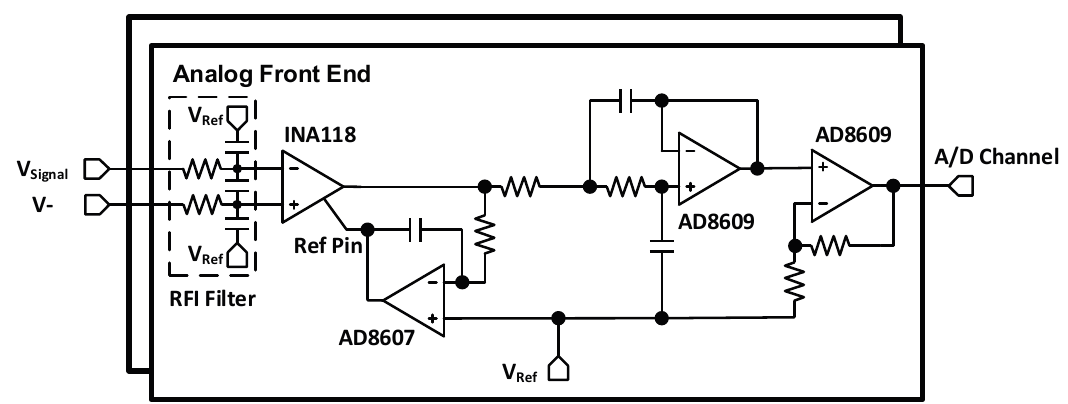
Figure 2. Schematic of the two-channel analog front-end.